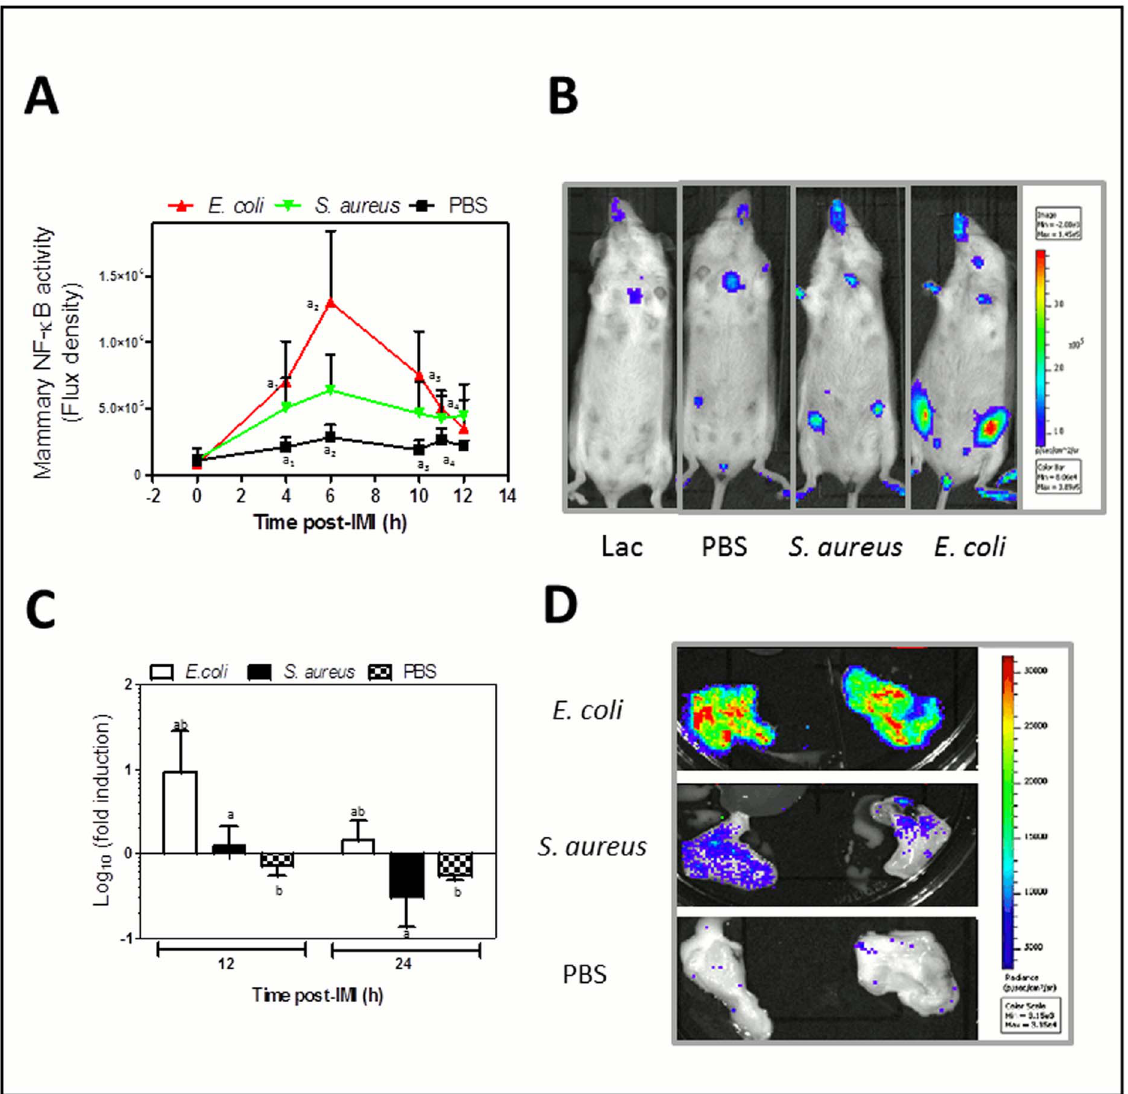
Figure 4. Invivo mammary NF-kappaB activity post-IMI with E.coli compared to S.aureus . (A) In vivo imaging of local NF-kappaB activity in mammary glands (ventral view) showed a transient and fast activation for both pathogens compared to sham-inoculated (PBS) glands and also about a 3-fold higher activation post-MI with E. coli compared to S. aureus . Data represent the flux density (total flux radiance per selected body area (in p*(s*m 2 ))) as a quantitative measure of the bioluminescent signal correlating with the NF-kappaB activity. (B) A representative photograph of lactating mice (at 0 h, most left) compared to mice at 6 h post-IMI with sham (PBS, 2nd from left), at 6 h post-IMI with S. aureus (3rd from left), or at 6 h post-IMI with E. coli (most right). The intensity of luminescence was scaled based on the radiance (in p*(s*m 2 )). (C) Mammary glands of NF-kappaB reporter mice were excised at 12 h and 24 h post-IMI and their ex vivo luminescence was measured. The graph represents the ratio between the total flux radiance per area (in p*(s*m 2 )) at 4 h of the inoculated gland and the value from the non-injected 3th gland in the same mouse. Although the maximal activation occurred earlier, the local NF-kappaB activity was still significantly higher in E. coli compared to S. aureus mammary glands at both these time points of relevance for cytokine transcription. (D) Representative photographical view of excised mammary glands post-IMI with E. coli (top), S. aureus (middle) or after sham-inoculation (PBS, bottom). Letters of homogeneous subsets were marked if the difference between treatments were statistically significant (P ,